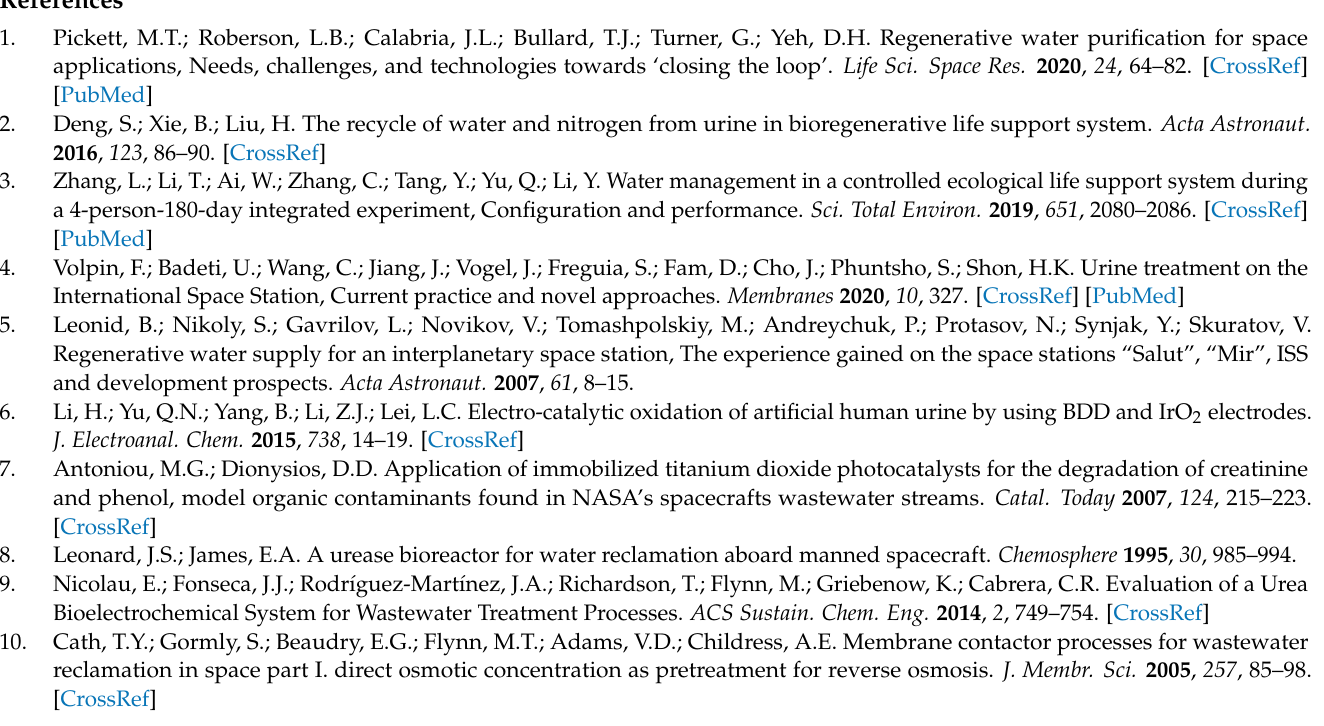
and microstructure of the outer surface (b) and inner surface (c) of the PP hollow fiber membrane, Figure S2: bacteria counts on spread plates for non-stabilized urine (a, 1:1000; b, 1:10,000) and stabi- lized urine (c, 1:1; d, 1:10), Figure S3: heat transformation from the evaporation surface to the feed stream during VMD, Figure S4: morphological and elemental analyses of membrane samples after 91% water recovery. SEM images of the membrane on outer surface (a) and inner surface (b); repre- sentative morphology of the fouling layer on the inner surface (c) and a cross-section (d); elemental analysis of a typical region in the fouling layer (e,f), Figure S5: image of the membrane modules after 30 batches of VMD testing (a) and local enlarged image of the fouled membrane (b), Figure S6: water contact angle change images of the virgin (a–d) and used (e–h, at the fouled position) PP hollow fiber membrane, Table S1: compositions of and concentrations in ersatz urine, Table S2: properties of the PP hollow fiber membrane; Table S3: the pH and conductivity of phenol solution at 25 ◦ C. Refs. [23,29,32,35,54–59] are cited in Supplementary